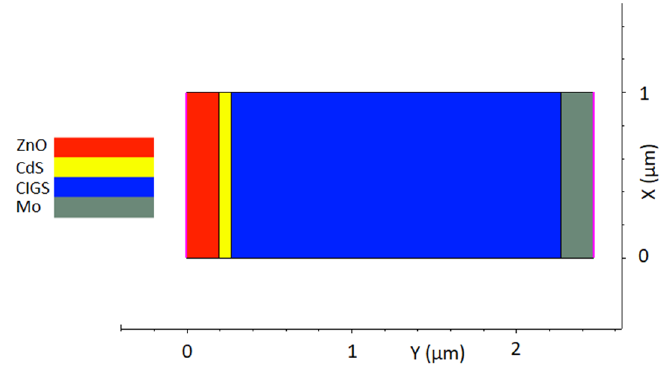
Figure 1. Model of the solar cell stack used in the simulations.